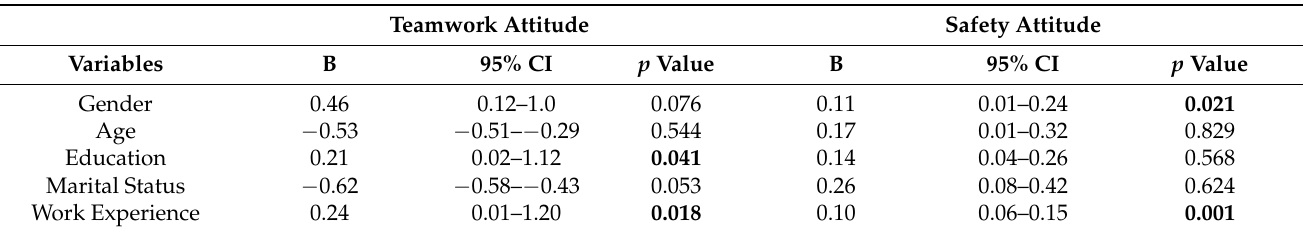
Table 5. Multiple regression analysis of the factors affecting teamwork attitude and safety attitude of